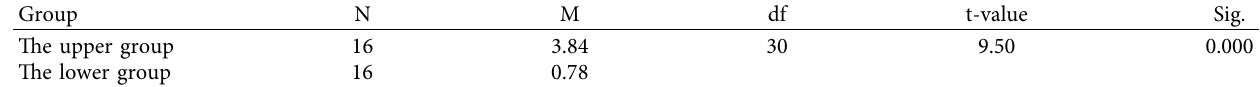
Table 1: The t -test for the difference between the upper and the lower groups.